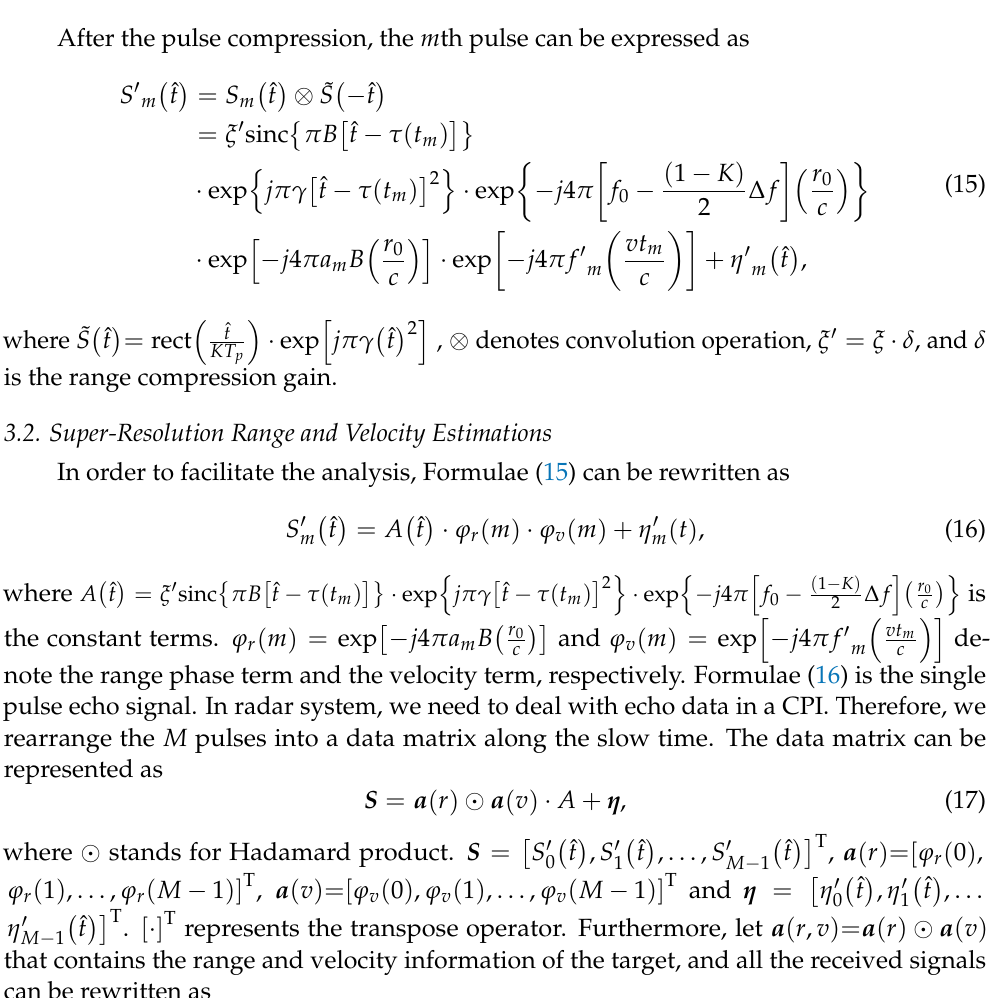
Figure 2. Block diagram of subcarrier synthesis